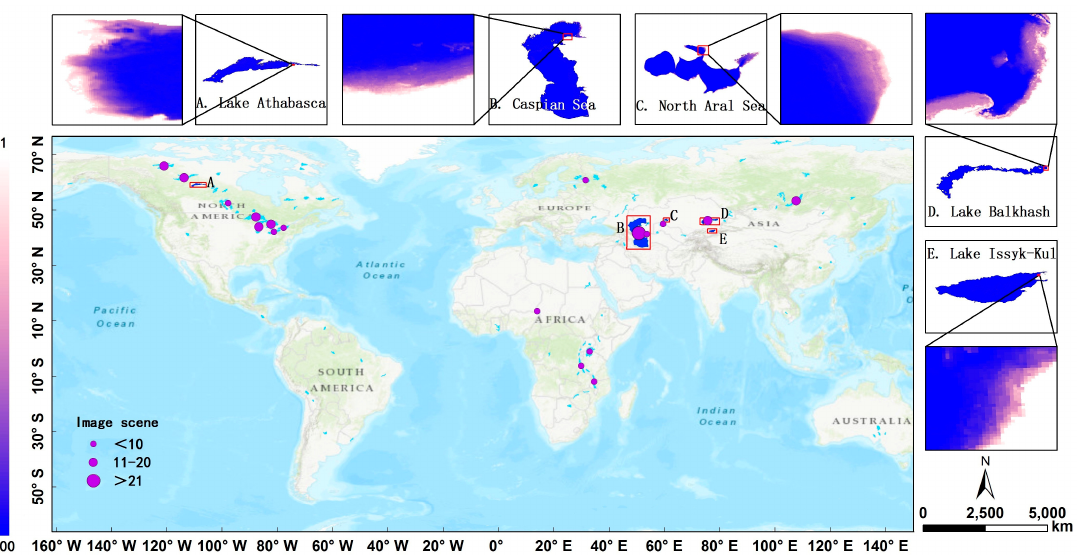
Figure 1. Geographical distribution of the five selected lakes including: ( A ) Lake Athabasca, ( B ) Caspian Sea, ( C ) North Aral Sea, ( D ) Lake Balkhash, and ( E ) Lake Issyk-Kul. Lake Athabasca, straddling the provinces of Alberta and Saskatchewan, is the fourth largest lake over northern Canada (58°35'31''N–59°37'37''N, 106°30'29''W–111°11'59''W). It covers a surface area of 7800 km 2 [8]. As shown in Figure 1, we chose a study area of approximately 20 km 2 in the eastern part of Lake Athabasca in 20-km west of Canadian city Fond-du-Lac. The terrain of the study region is relatively flat and its lake water depth is shallow. It can sensitively reflect the lake area changes with the water level